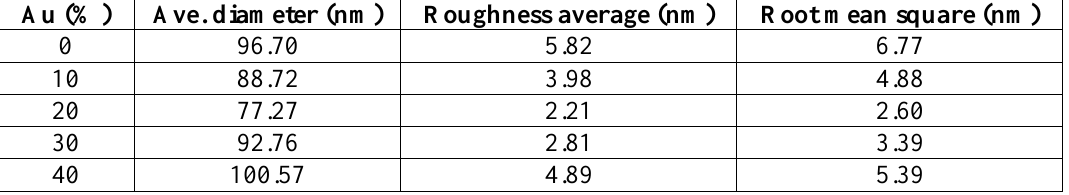
and doping with different ratio of Au thin films 3 =400 a